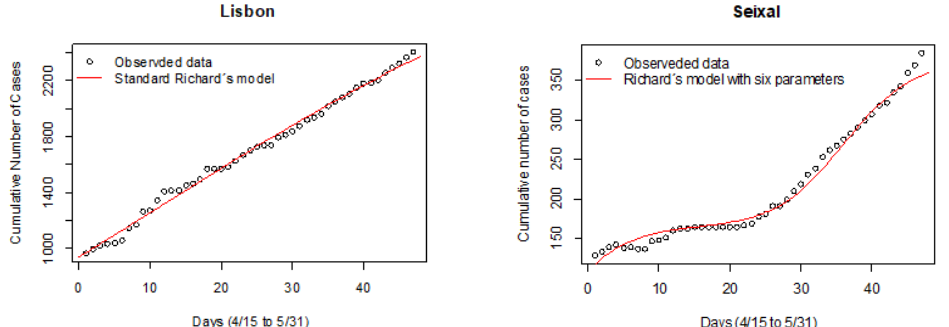
Figure 2. Richards model (red line) fit with observed data for Lisbon and Seixal counties between 4/15 and 5/31 . The empirical data are indicated by empty